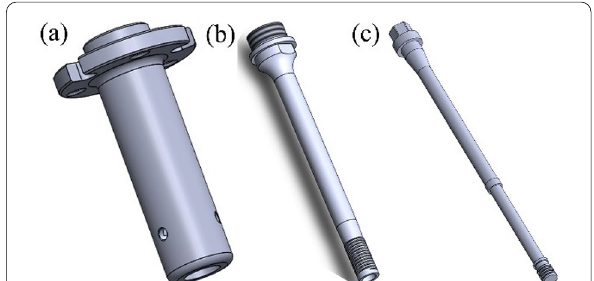
Figure 2 Geometrical feature of ( a ) clamping ring, ( b ) sleeve and ( c )